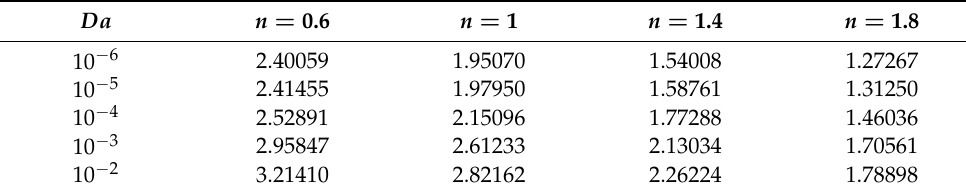
Table 6. The values of the average Nusselt number ( Nu avg ) at the heated boundary.